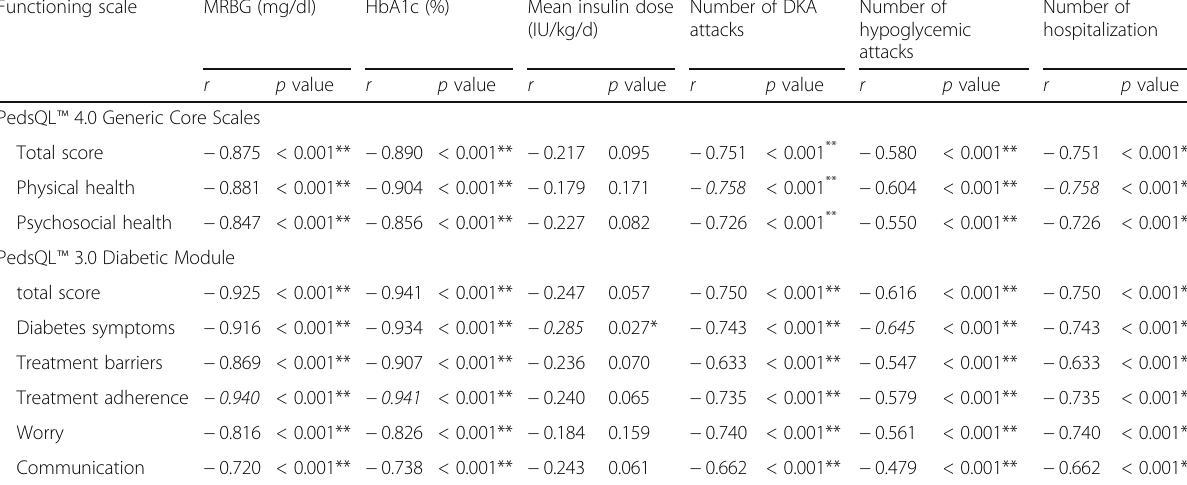
Table 7 Correlation between Pediatric Quality of Life Inventory scores with metabolic control parameters of type 1 diabetes in the studied diabetic